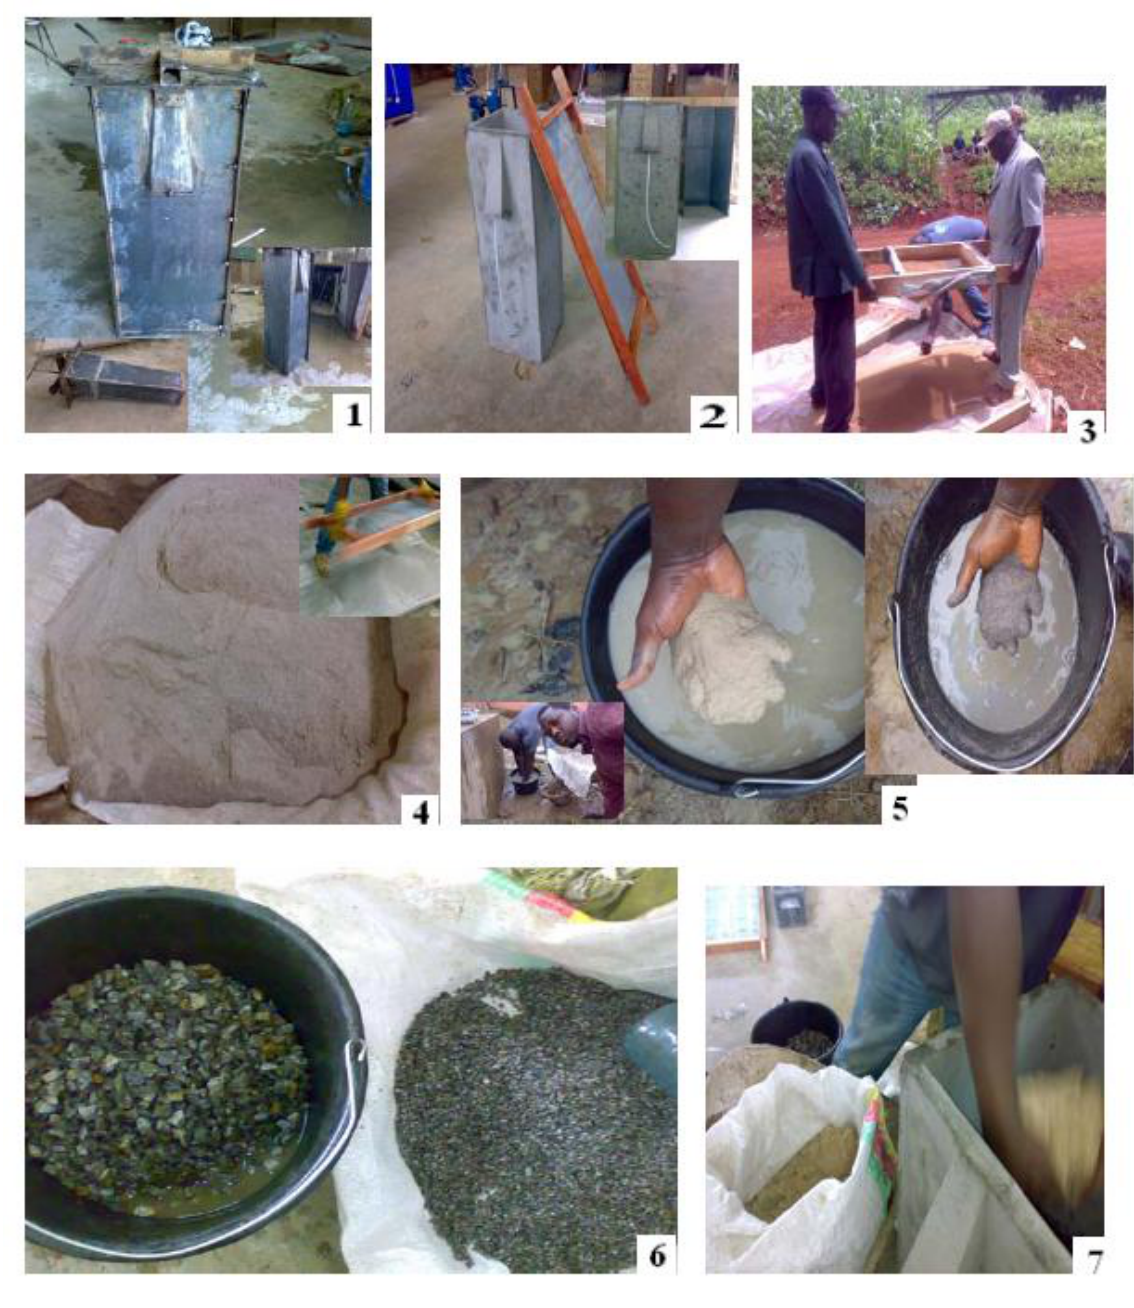
Figure 2. Plates showing the steps used in the construction, media preparation, and operation of the concrete intermittent bio-sand